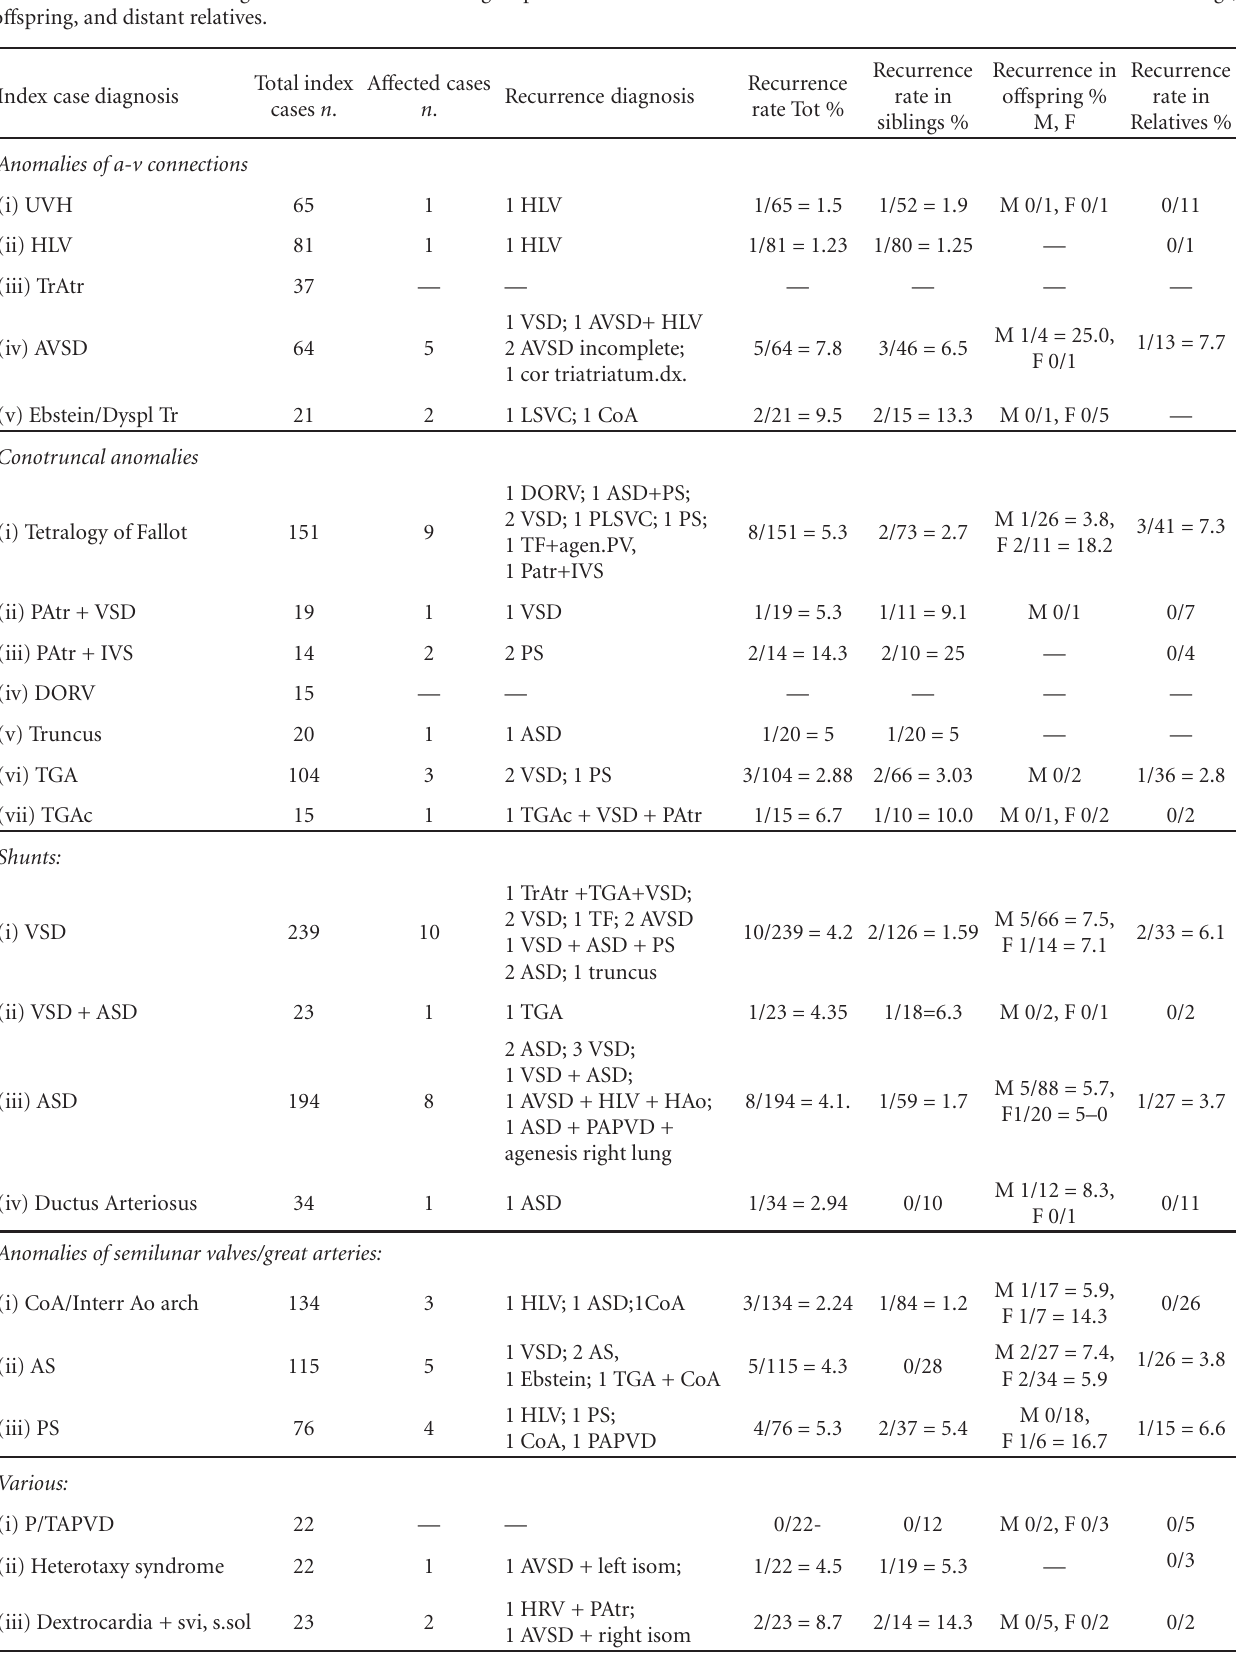
Table 2: Recurrence of congenital heart defects in subgroups of CHD in index cases: total recurrence rate and recurrence rates in siblings, o ff spring, and distant